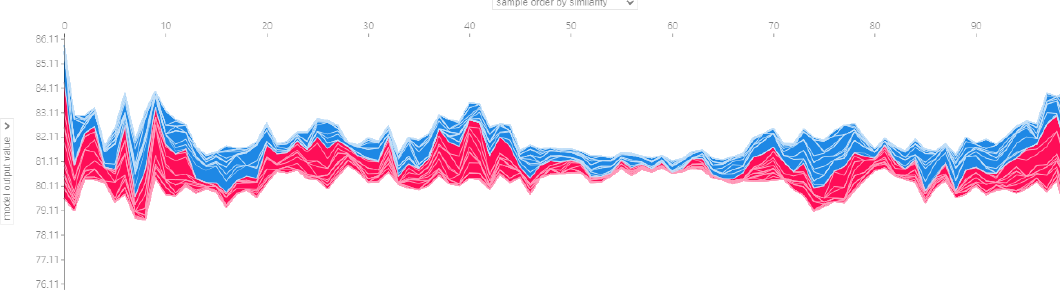
Figure 9. SHAP force plot of FD001 dataset.